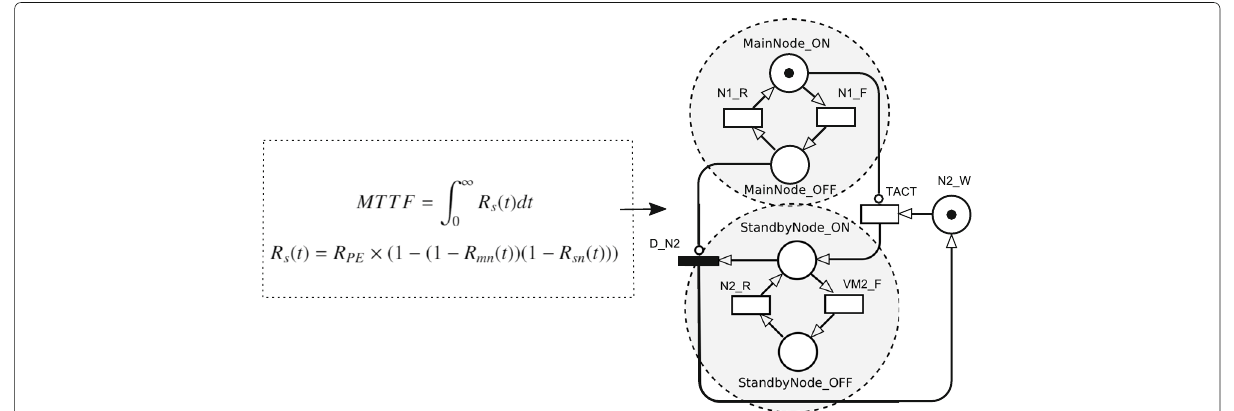
Fig. 3 An illustrative example of a SPN model for a node with a cold-standby redundancy